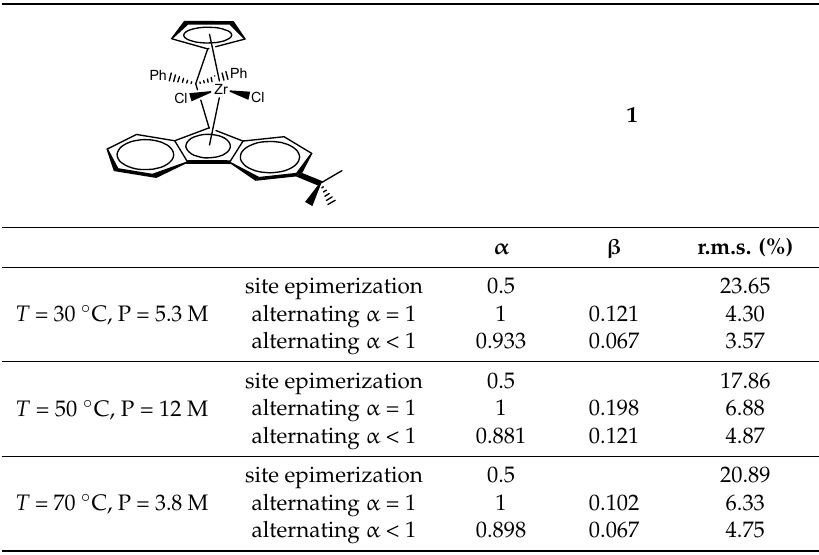
Table 5. The r.m.s. errors for given statistical models for propene polymerizations made with 1